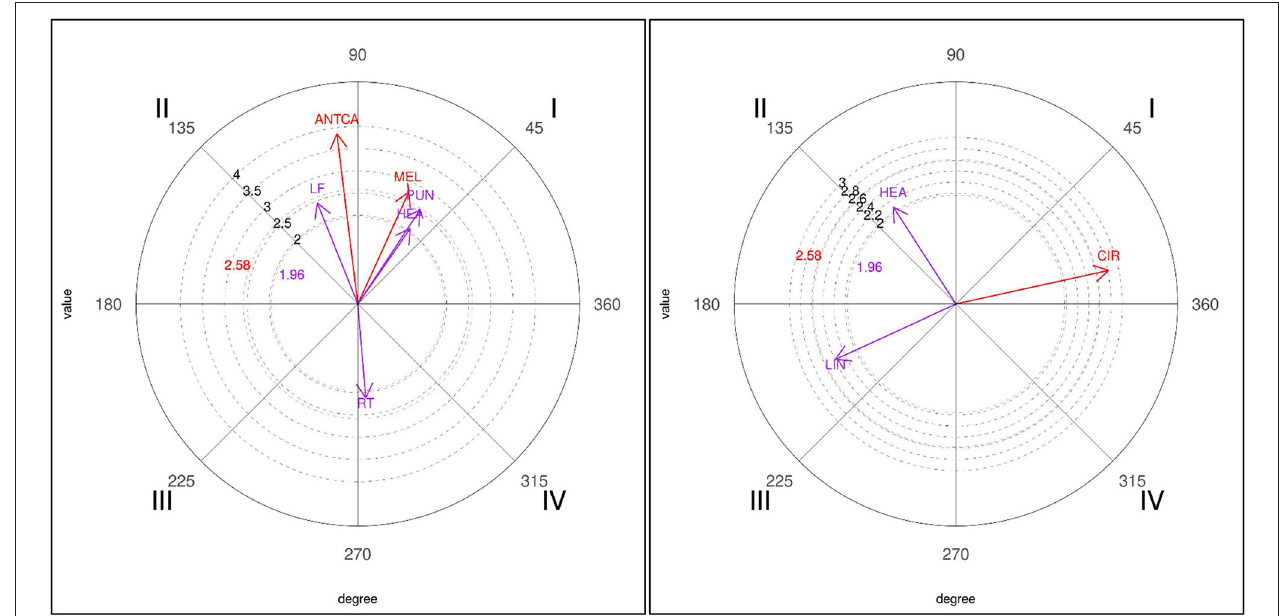
FIGURE 3 | Representation of the behavioral map for the 3P focal behavior in winners (left) and losers (right).